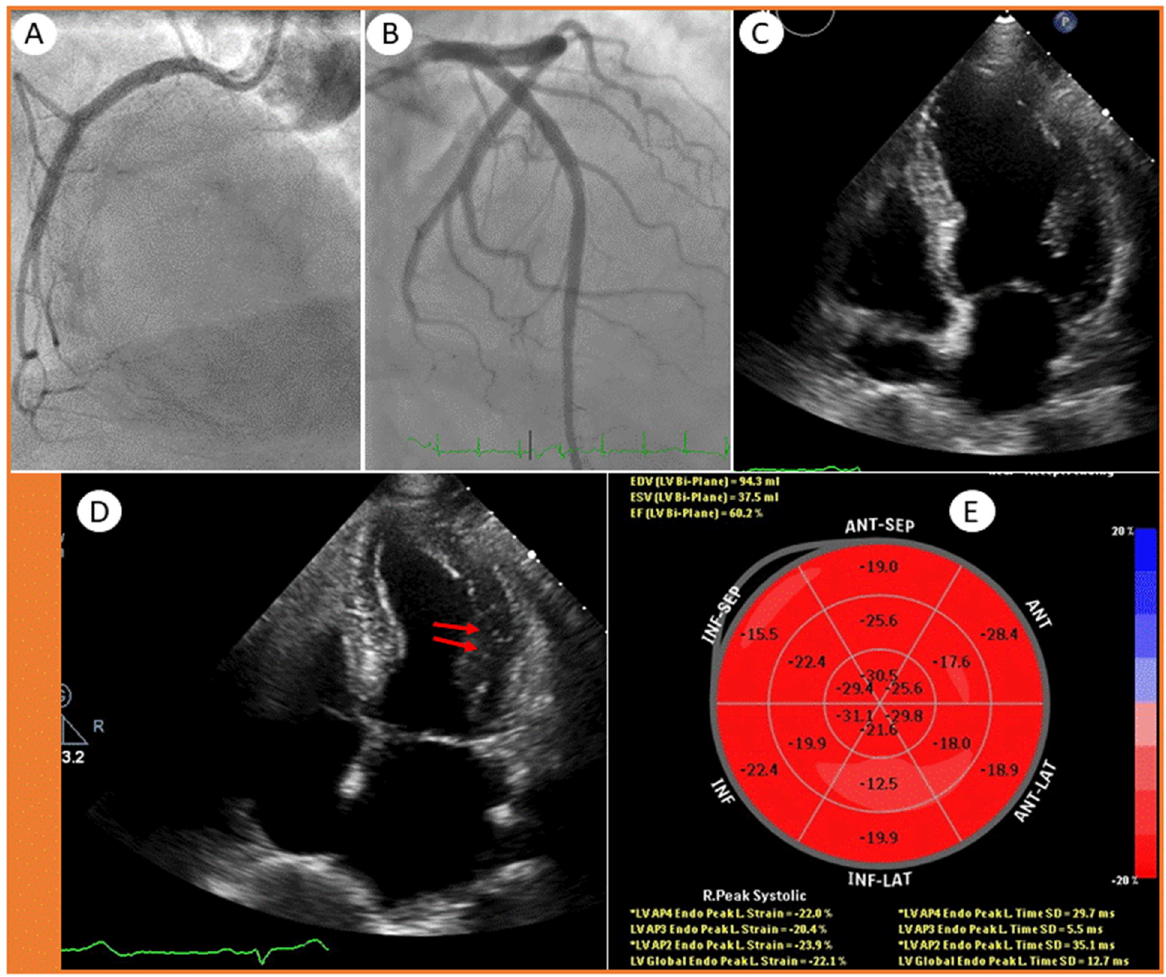
Figure 2. Coronary angiography showing a ( A ) normal right coronary artery and ( B ) normal left main stem, left circumflex artery with marginal branches and left anterior descending artery with diagonal branches. Echocardiographic 4-chamber views showing ( C ) end-diastolic and ( D ) end-systolic frames with mild hypokinesis (arrows), and a ( E ) Bulls’ eye plot.